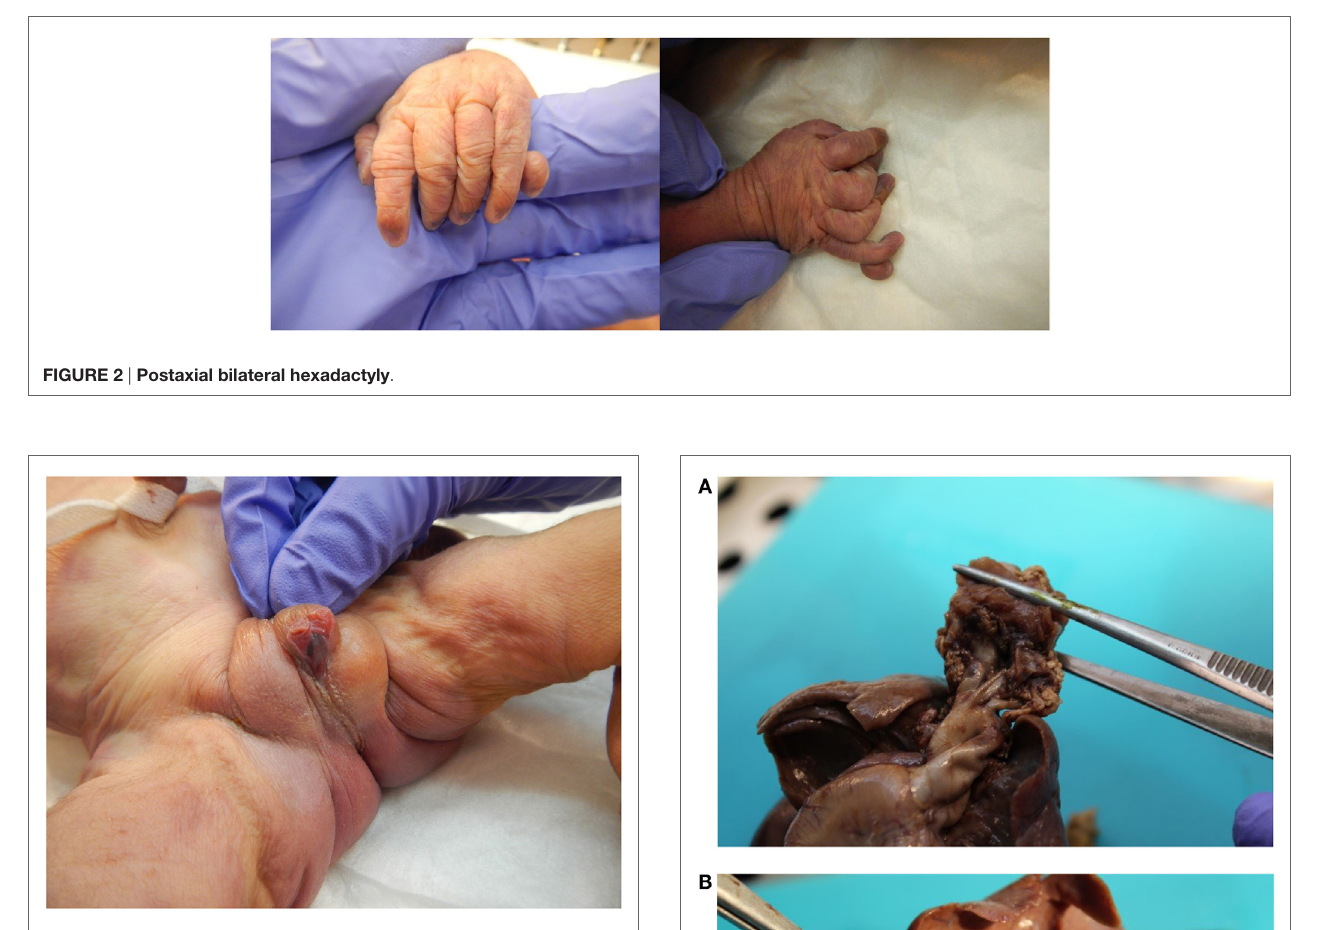
FIGURe 3 | penile hypoplasia and perineoscrotal hypospadias .